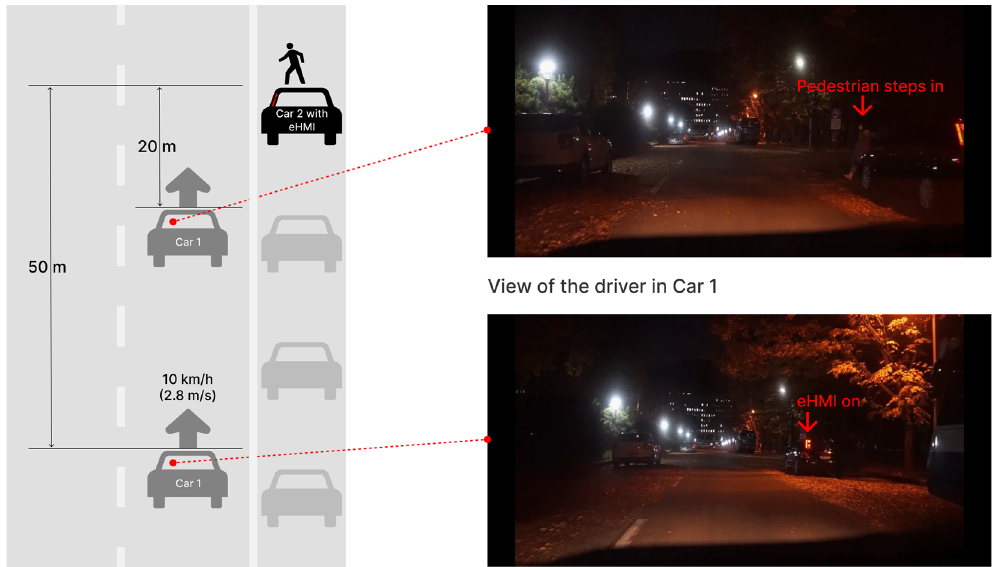
Figure 1. Test scenario filmed at night.